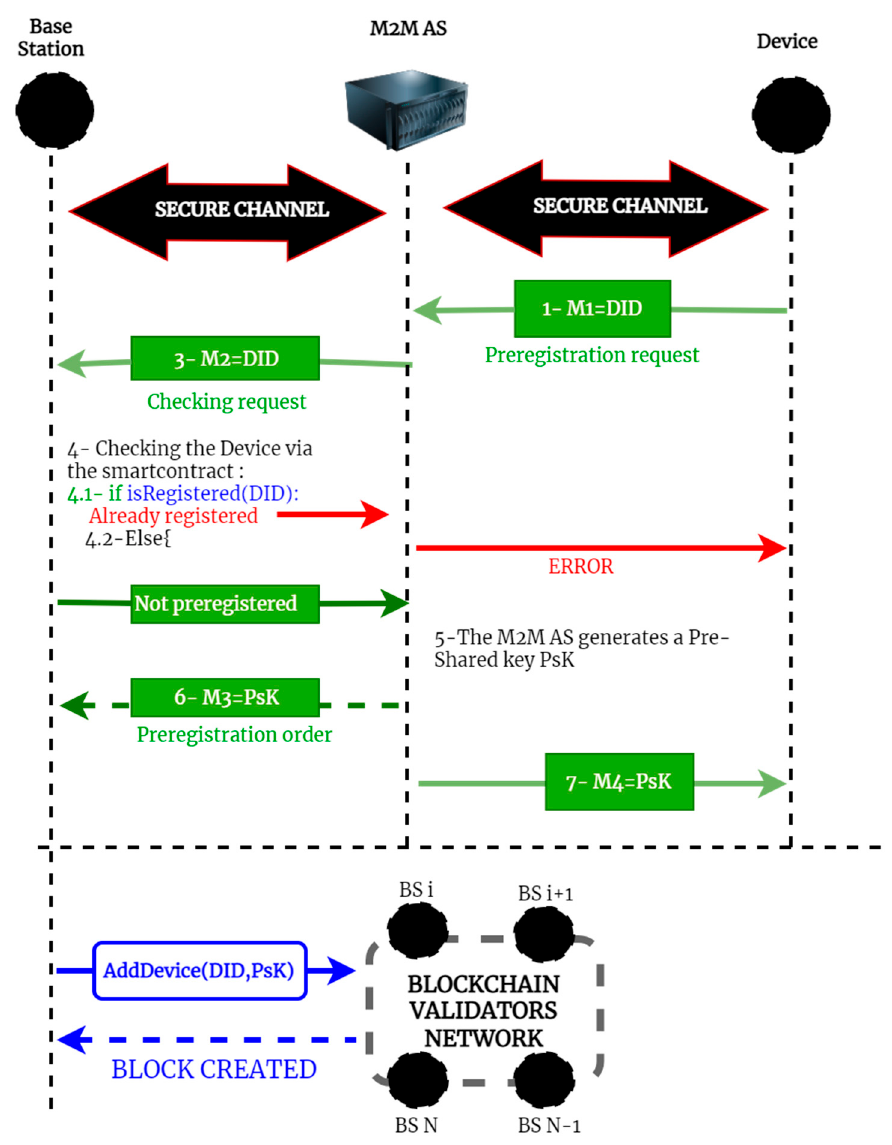
Figure 5. Pre-registration phase